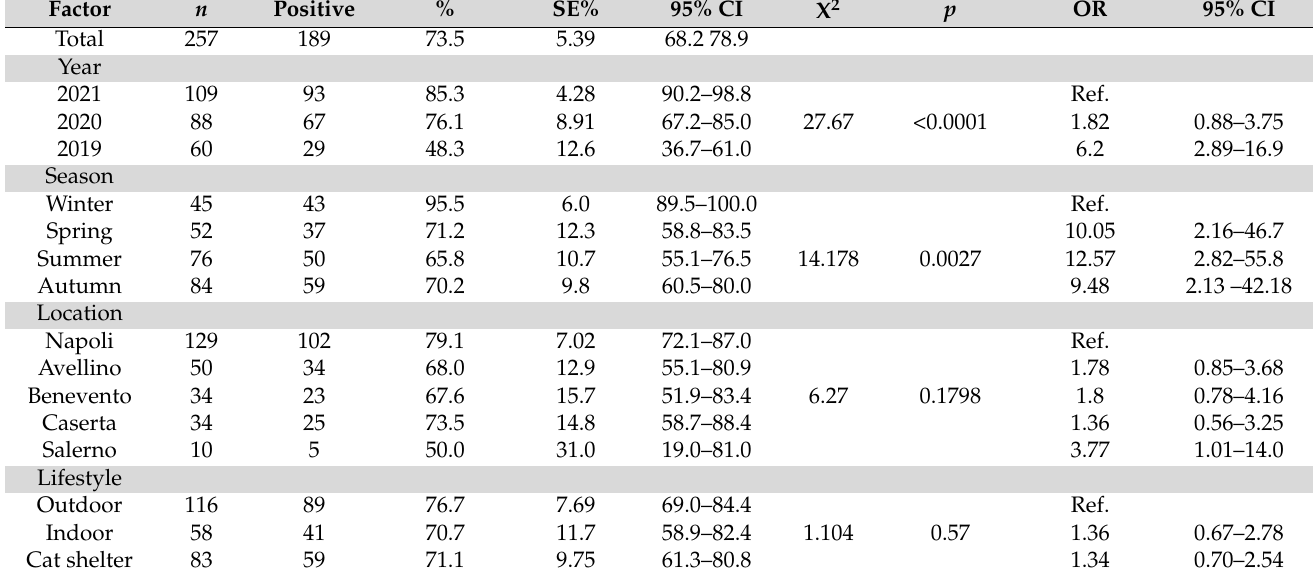
Table 3. FPV prevalence of infection and risk factor analysis in cats from Campania Region